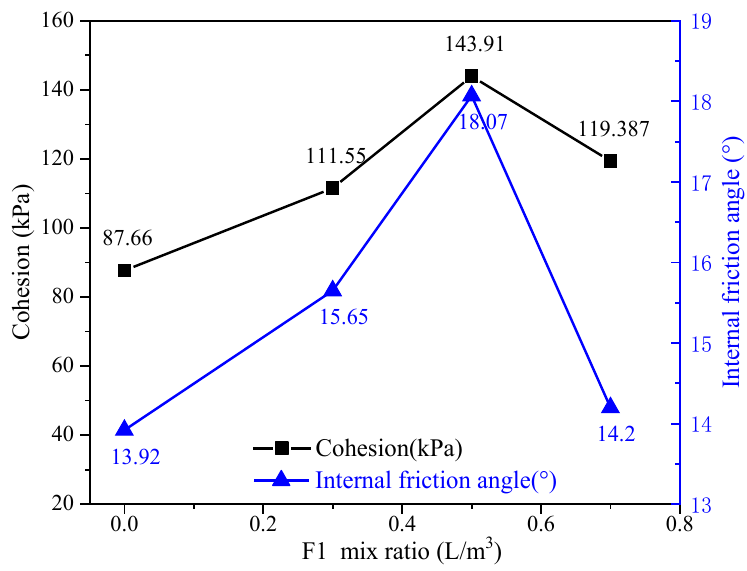
Figure 7. Relationship between shear strength parameters of red clay and F1 content.